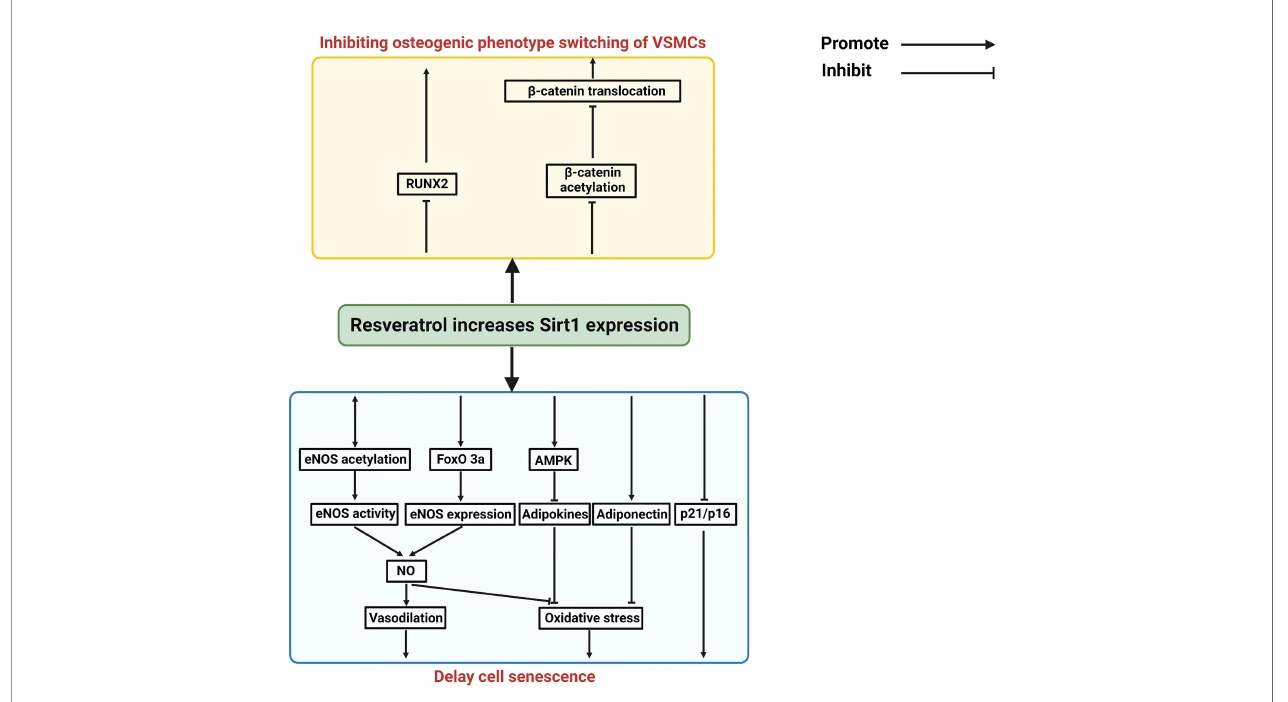
FIGURE 2 | Summary on the mechanisms of Sirt1 in mediating vascular calci fi cations in CKD